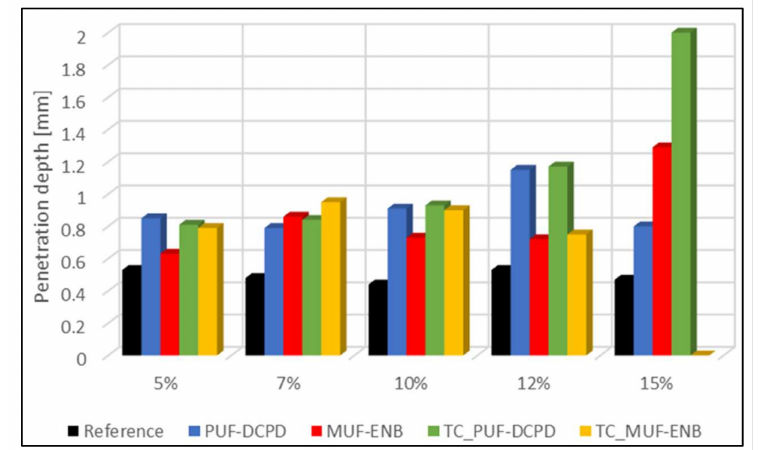
Figure 14. Penetration depth vs. microcapsule